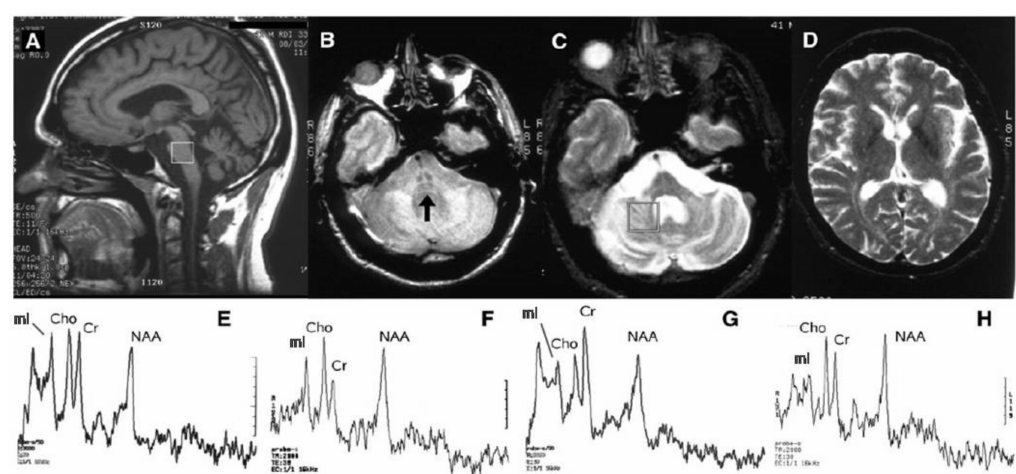
Figure 1. MR imaging and proton MR spectroscopy in a symptomatic 41-year-old man with SCA2. Sagittal T1 weighted ( A ), axial proton density ( B ) and T2 weighted ( C ) images show a pattern consistent with olivopontocerebellar atrophy with evidence of the “cross sign” (arrow) in ( B ). The T2 signal in the basal ganglia ( D ) is normal. Proton MR spectroscopy (STEAM TR 2000 ms TE 30 ms) of 8 mL single voxels placed in the basis pontis (white square in A) of the SCA2 patient ( E ) and of a healthy control ( F ), and in the deep right cerebellar hemisphere (white square in C) of the SCA2 patient ( G ) and of the healthy control ( H ), show lower NAA / Cr, Cho / Cr and NAA / mI ratios in the SCA2 patient in both locations. Modified and reproduced with permission fromMascalchi M. and Vella A.: